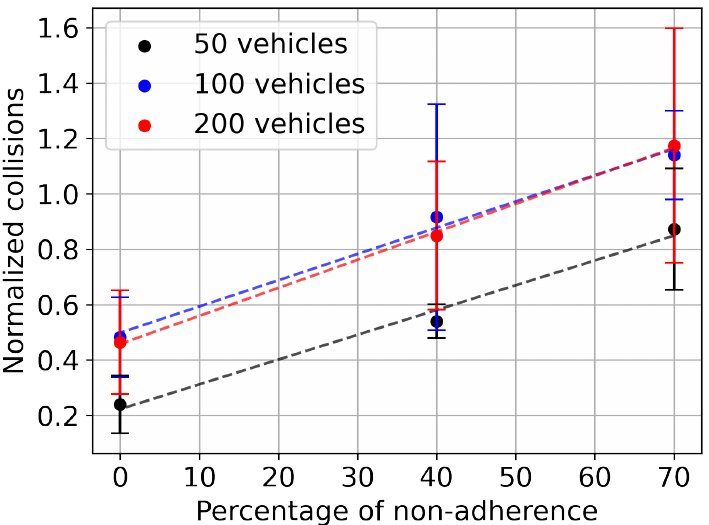
Figure 4. Number of collisions (normalised by number of vehicles) against the percentage of non- adherence to speed limits, refer to Supplementary Materials for data